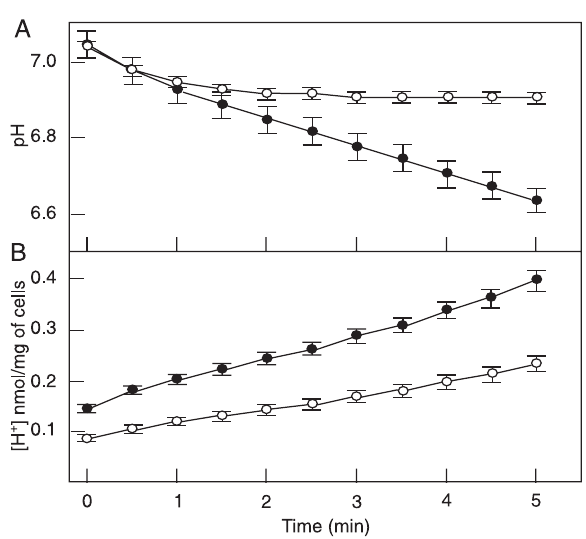
Figure 2. Glycolytic pH profile (A) and proton release reported as nmol H + /mg (dry weight) of cells (B) by intact Streptococcus mutans ATCC 25175 (filled circles) and permeabilized cells (open circles) incubated with a limiting supply of glucose (10